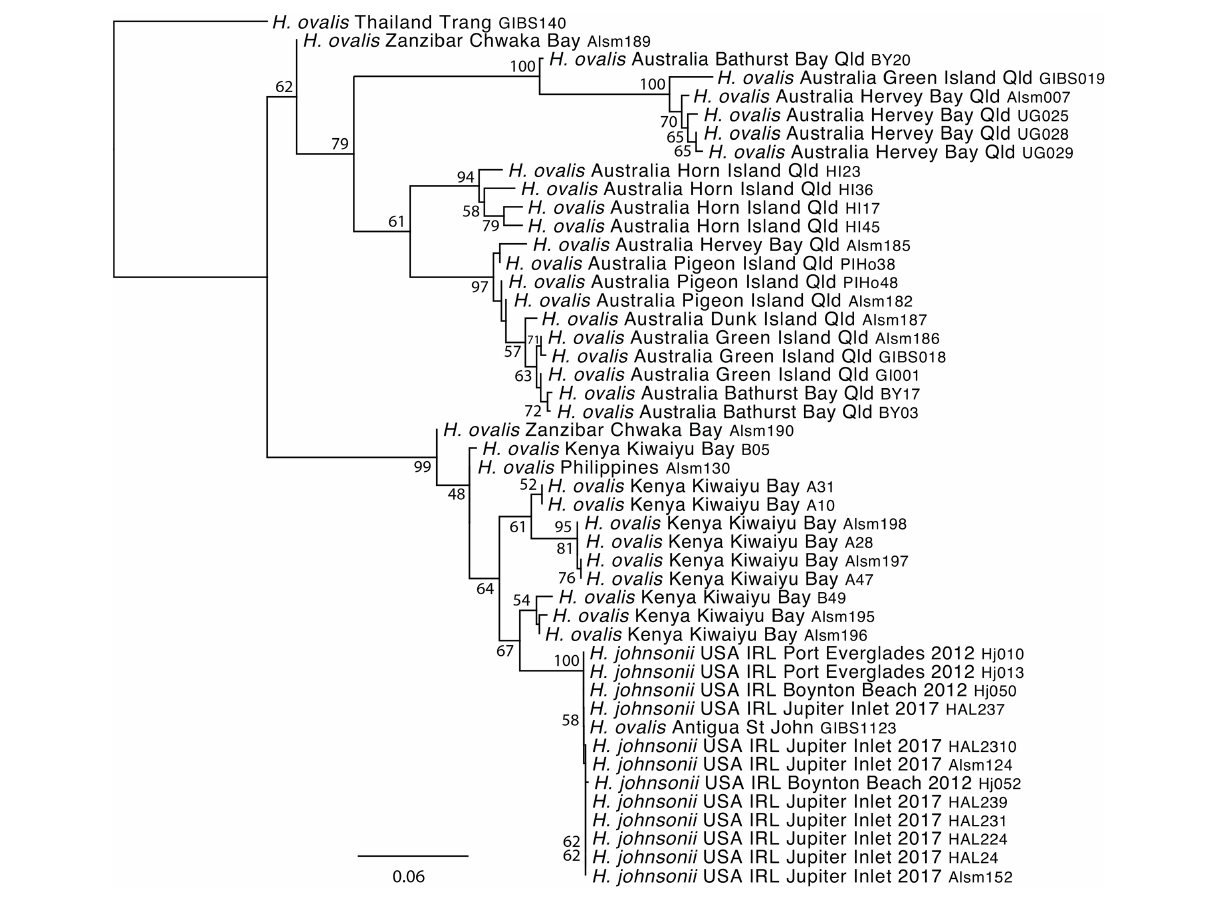
FIGURE 4 | Phylogenetic relationships based on analysis of 990 ddRAD SNPs generated for samples of Halophila johnsonii and the H. ovalis complex ( Supplementary Table 1 ) using RAxML, the GTR Gamma I nucleotide substitution model and 500 bootstrap replicates. Support values ≥ 80% are shown adjacent to the node and unlabeled nodes had support values lower than this